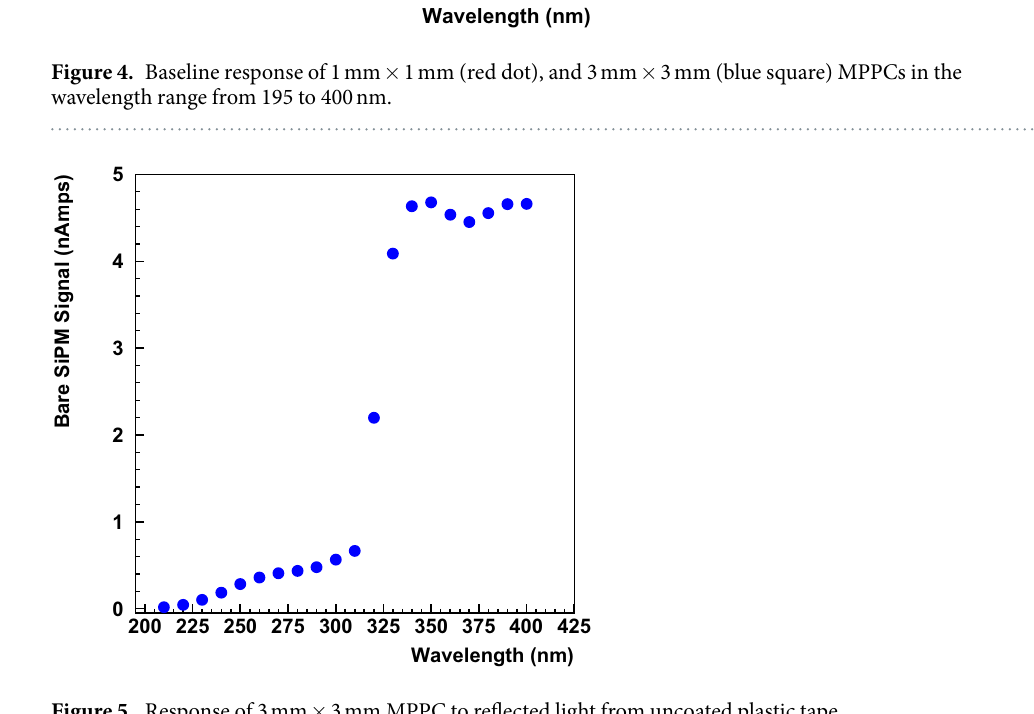
Figure 5. Response of 3 mm × 3 mm MPPC to reflected light from uncoated plastic